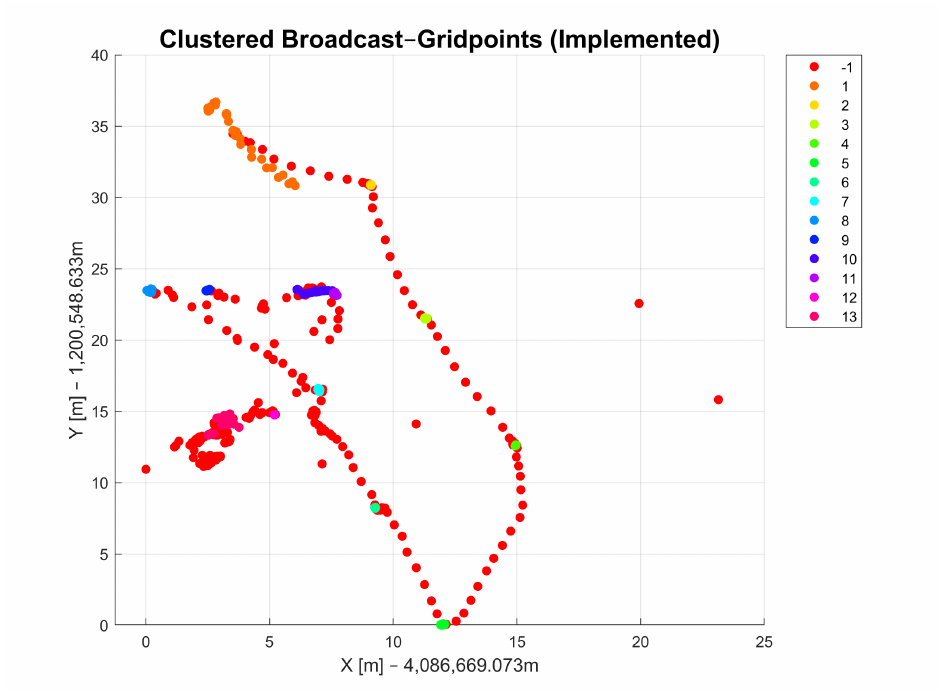
Figure 6. Results of DBSCAN-derived clustering